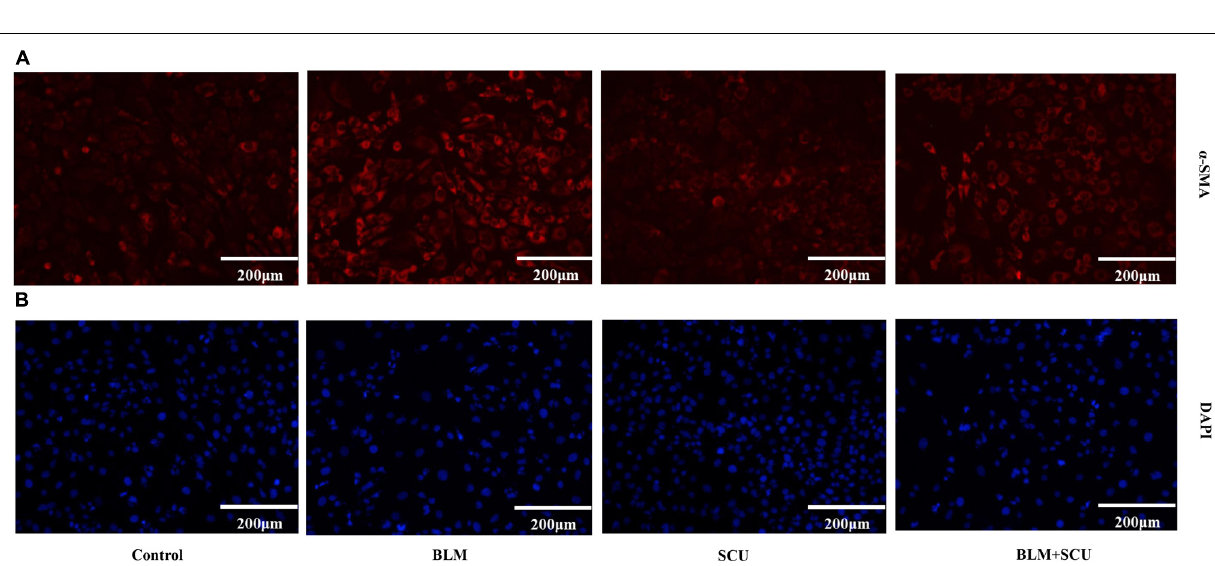
FIGURE 9 | Effects of BLM, SCU, and their combination on the expression of α -SMA. ( A , × 200) Immunofluorescence staining was performed to measure α -SMA protein expression (red) in MRC-5 cells. ( B , × 200) The nuclei were stained by 4 (cid:48) ,6-diamidino-2-phenylindole (DAPI) (blue). Representative images of each group are shown. Scale bar indicates 200 µ